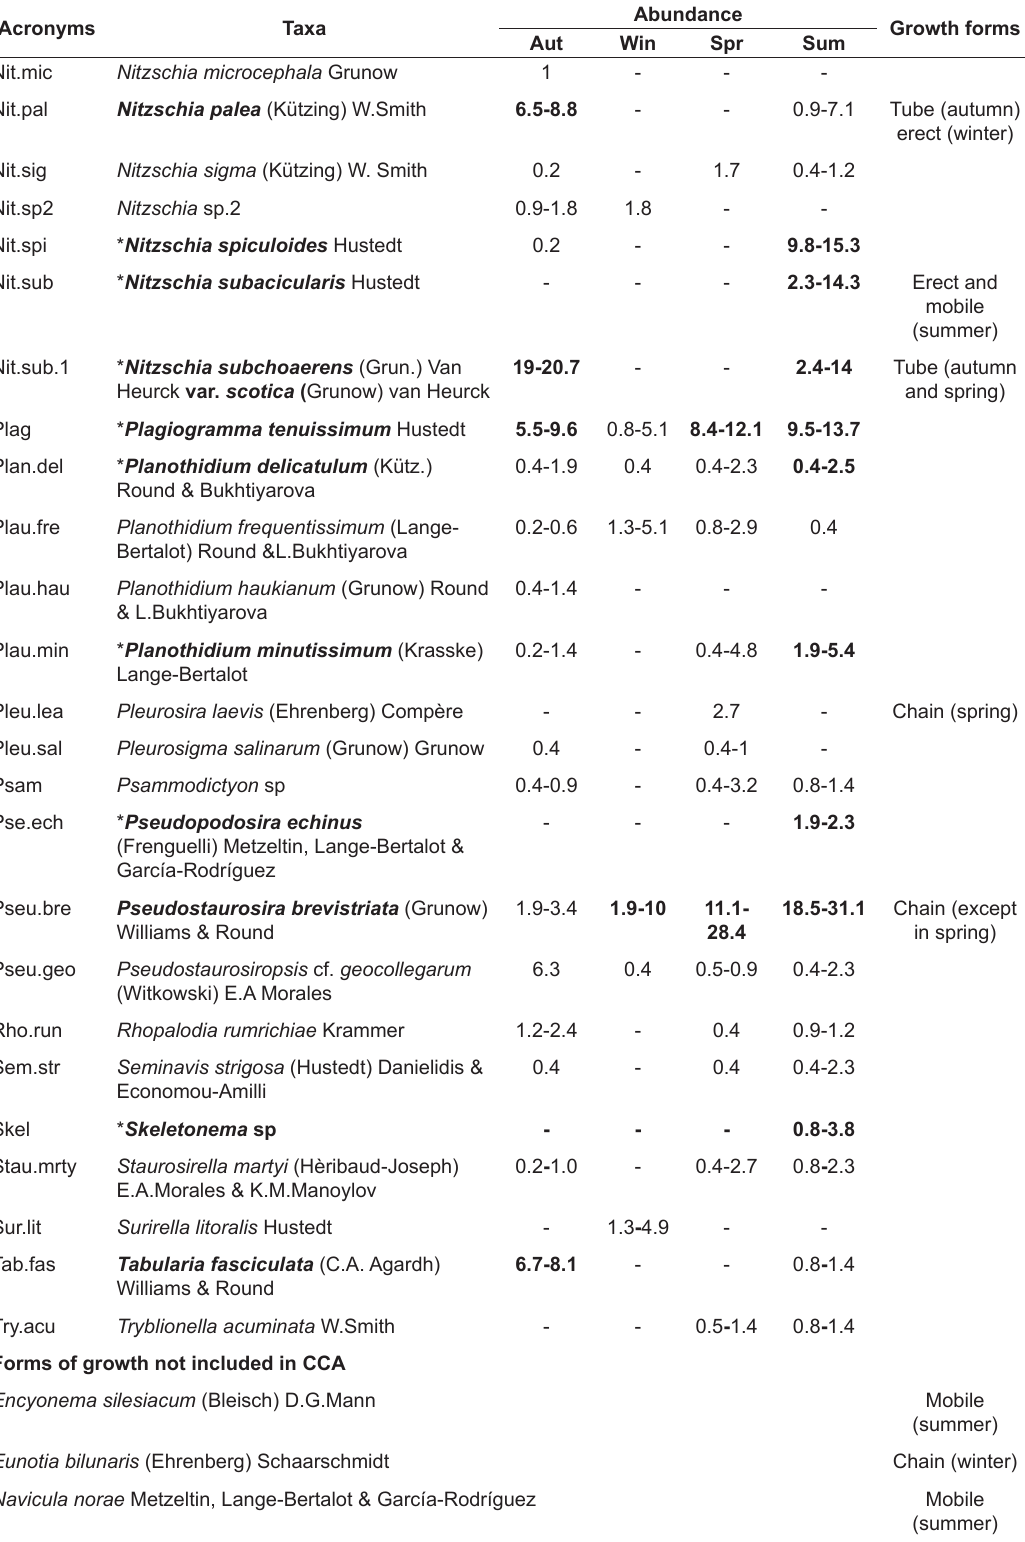
Tabularia tabulata (C.A. Agardh) Snoeijs Erect